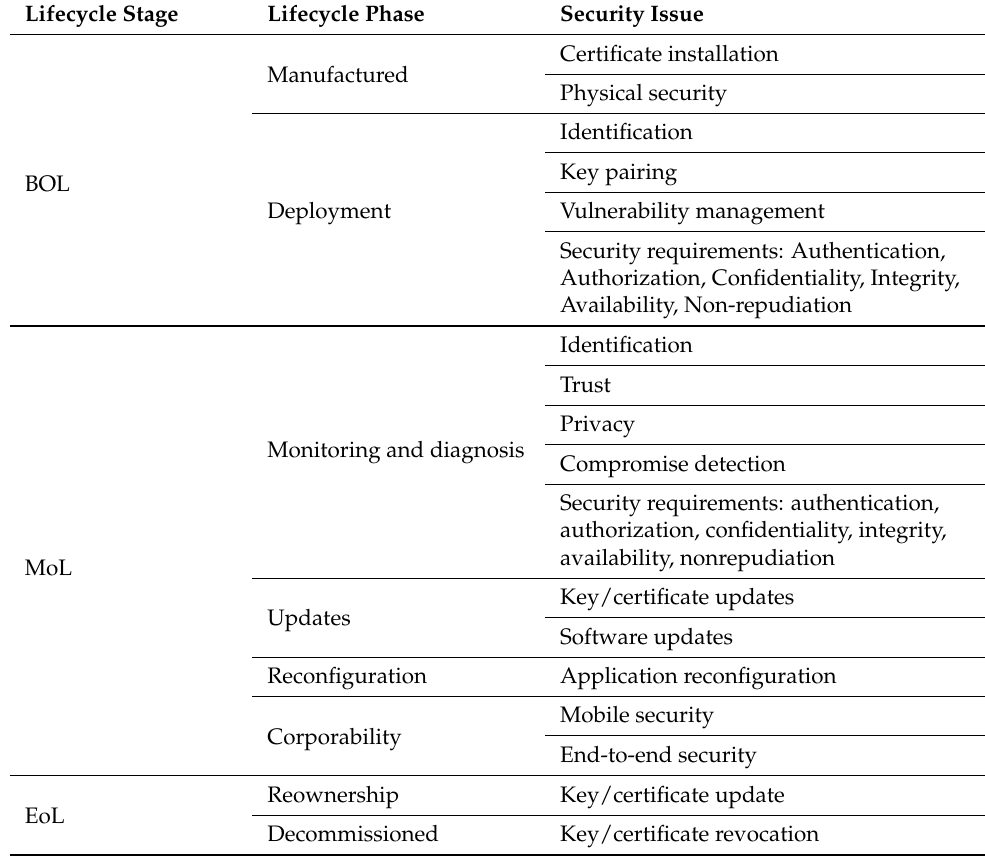
Table 2. Classification of security